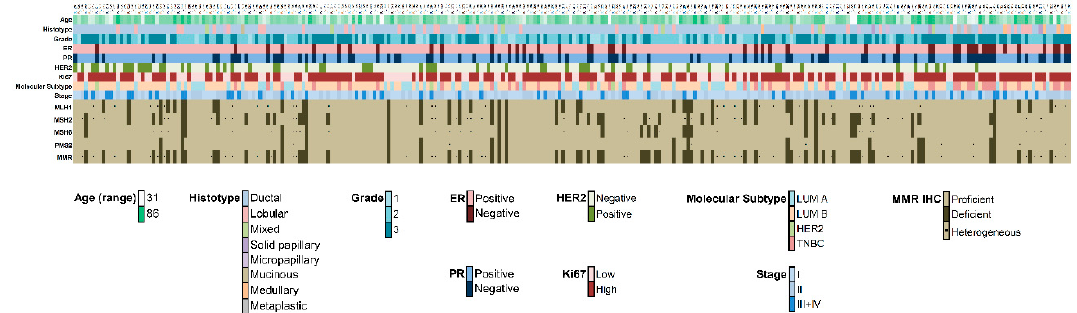
Figure 1. Overview of 280 PTEN-low breast carcinomas. Heatmap illustrating the clinical, histologic, and biological information together with mismatch repair protein status of all PTEN low (i.e., scores 0 and 1) cases identified. Each column represents a case, each row a parameter, which is color-coded according to the legend below. ER, estrogen receptor; PR, progesterone receptor; MLH1, mutL homologue 1; MSH2, mutS homologue 2; MSH6, mutS homologue 6; PMS2, postmeiotic segregation increased 2 (PMS2); MMR, mismatch repair; LUM A, Luminal A; LUM B, Luminal B; TNBC, triple-negative breast cancer; IHC, immunohistochemistry.